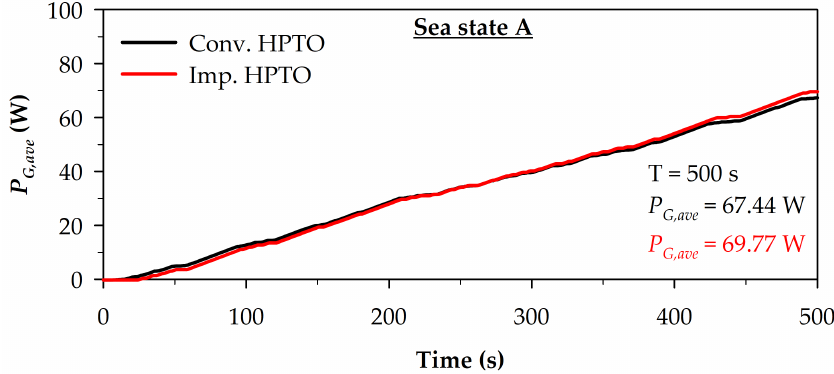
Figure 15. A comparison of P G , ave for conventional and improved HPTO unit models in sea state